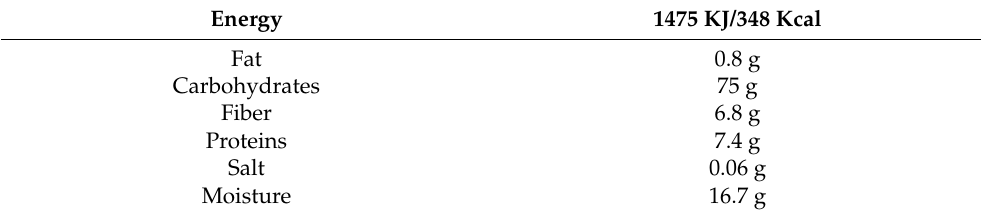
Table 1. Puree potato’s nutritional value per 100 g of